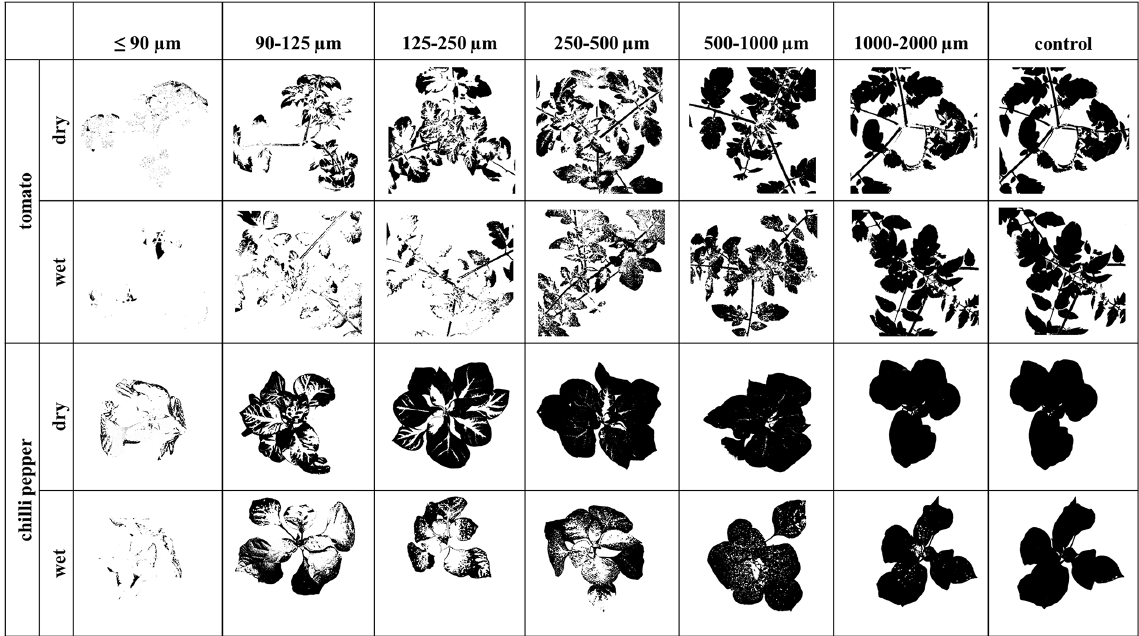
Figure 3. Photos processed with ImageJ of tomato and chilli pepper plants before (control) and after exposure to ∼ 570gm − 2 of ash varying in grain size ( ≤ 90, 90–125, 125–250, 250–500, 500–1000, 1000–2000µm) and in dry and wet conditions at leaf surfaces. The part of the foliar cover depicted in black corresponds to the green leaf surface area that was not covered with ash. The image surface area is equivalent to ∼ 800cm 2 . The original photos of the ash-covered plants are provided in the Supplement (Fig.